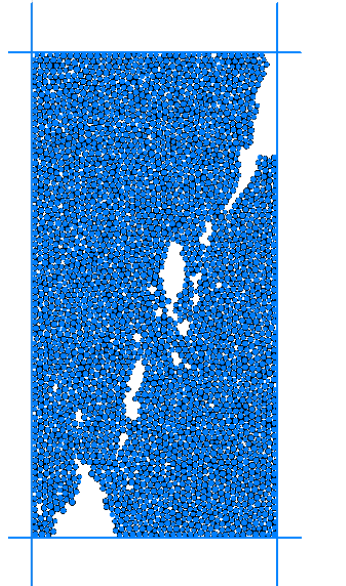
Table 2. Macro parameters of biaxial compression test.